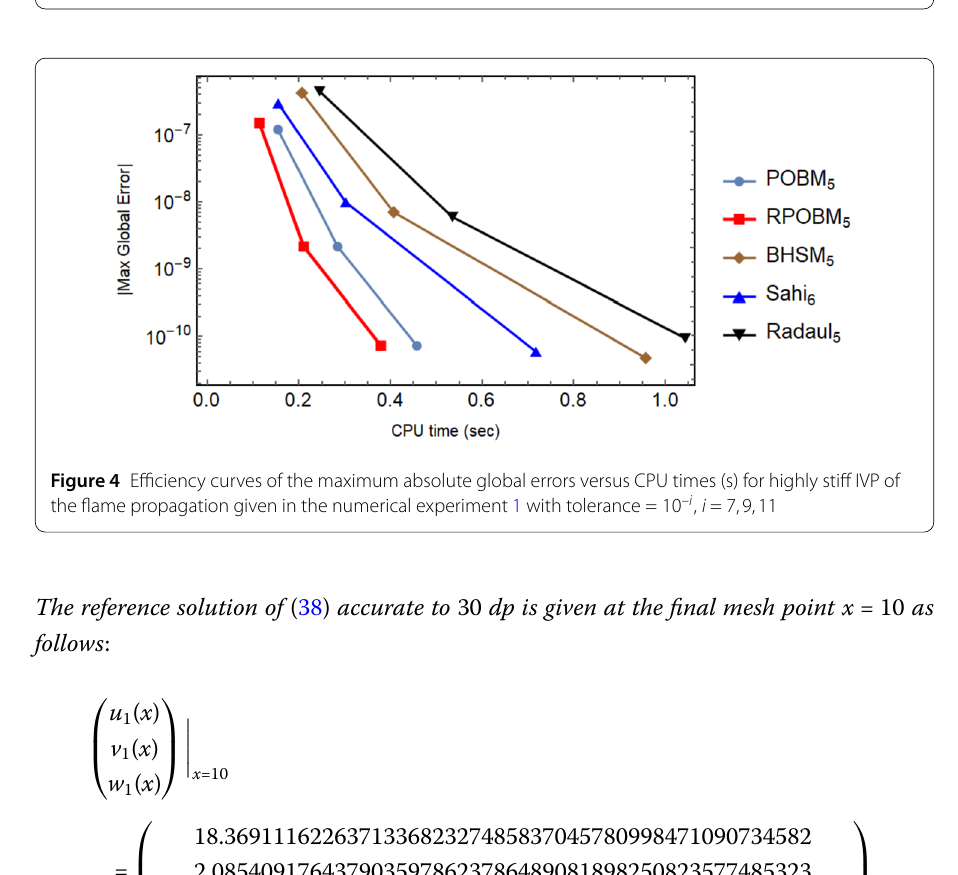
Figure 3 Efficiency curves of the maximum absolute global errors versus CPU times (s) for highly stiff IVP of the flame propagation given in the numerical experiment 1 with tolerance = 10 – i , i = 7,9,11